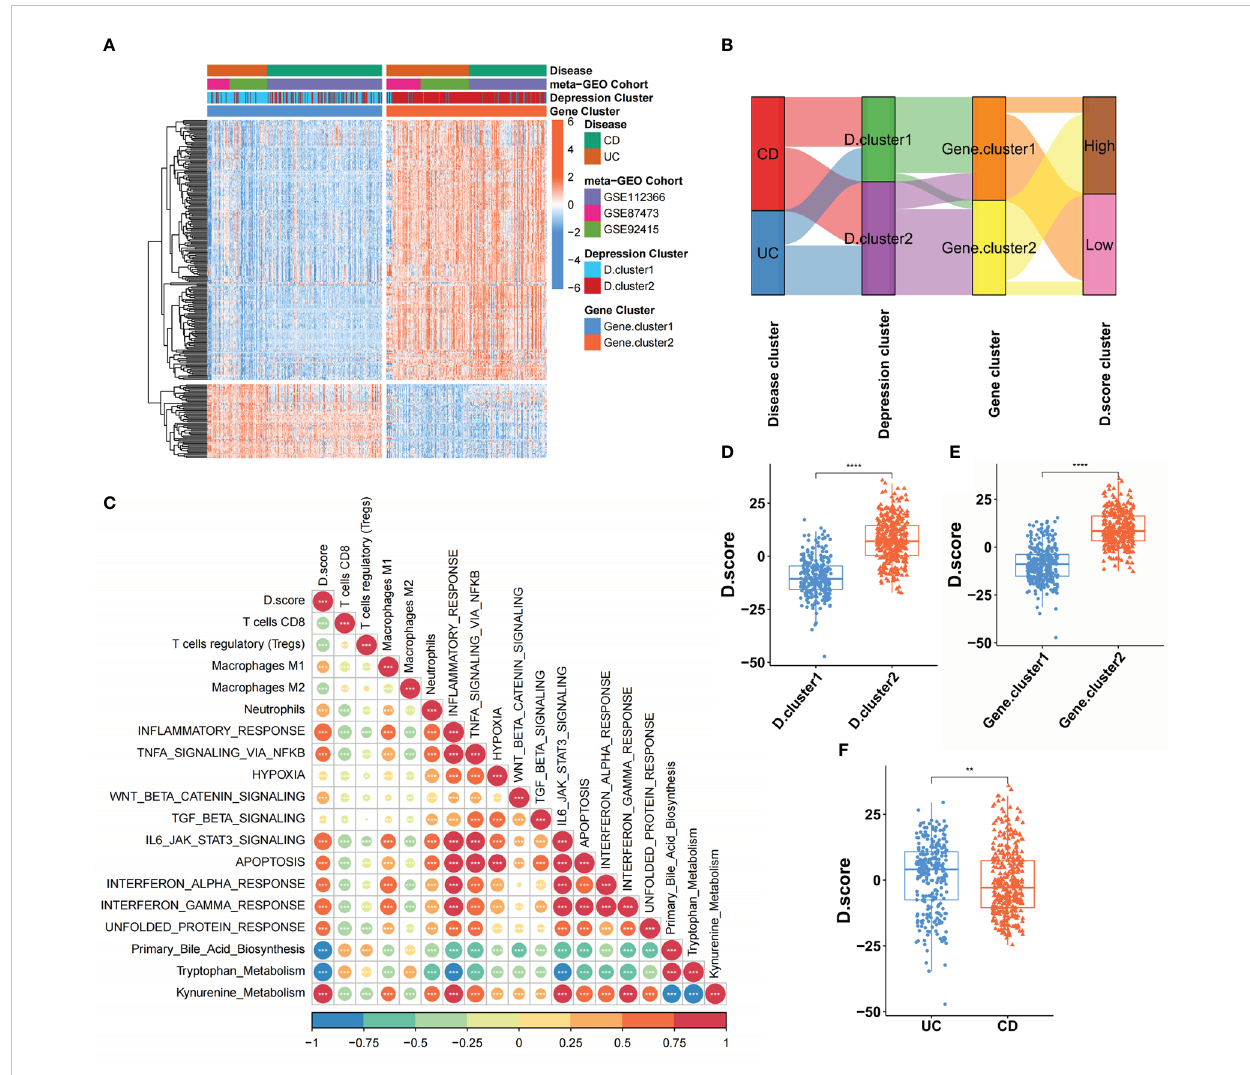
FIGURE 4 Construction of the Depression score (D. score) of IBD and exploration of its clinical relevance. (A) Unsupervised clustering of DEGs among the two molecular subtypes to classify patients into different genomic subtypes termed as the gene. cluster 1 and gene. cluster 2 respectively. The gene signature subtypes, (D) clusters, and disease subtypes were used as patient annotations. (B) Alluvial diagram showing the changes of D.clusters, disease subtypes, gene clusters and D.score. (C) Correlations between D.score and the known gene signatures in meta-cohort using Spearman analysis. A negative correlation was marked with blue and a positive correlation with orange. (D) Differences in D.score between two (D) clusters in GEO meta-cohort. (E) Differences in D.score between two gene clusters in GEO meta-cohort. (F) Differences in D.score between two disease subtypes in GEO meta-cohort. The asterisks represented the statistical p-value (**P < 0.01; ****P <